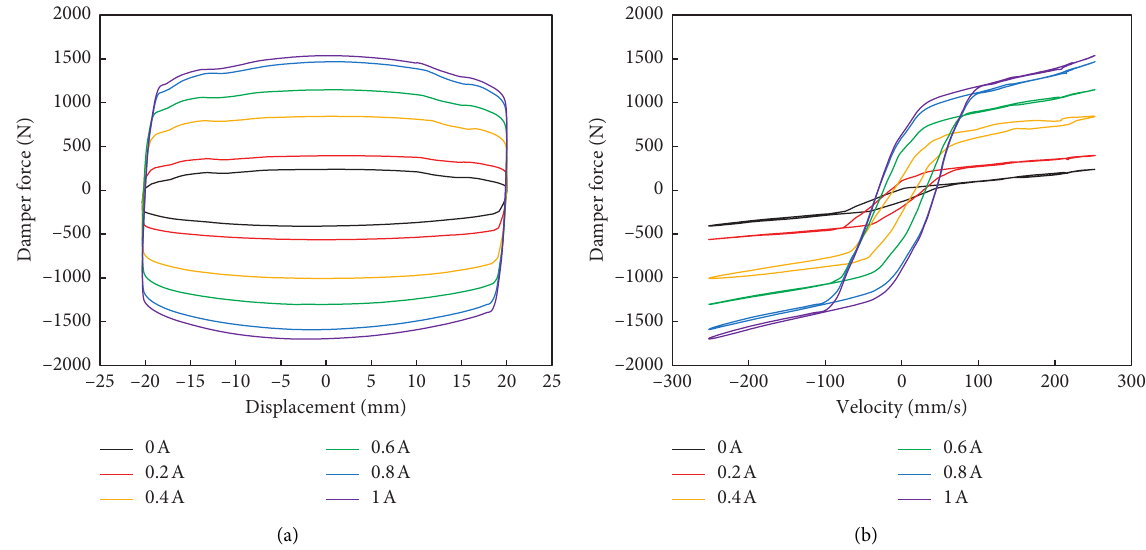
Figure 3: Mechanical properties of different currents, frequency � 2 Hz, and amplitude � 20 mm. (a) Damper force-displacement. (b) Damper force-velocity.